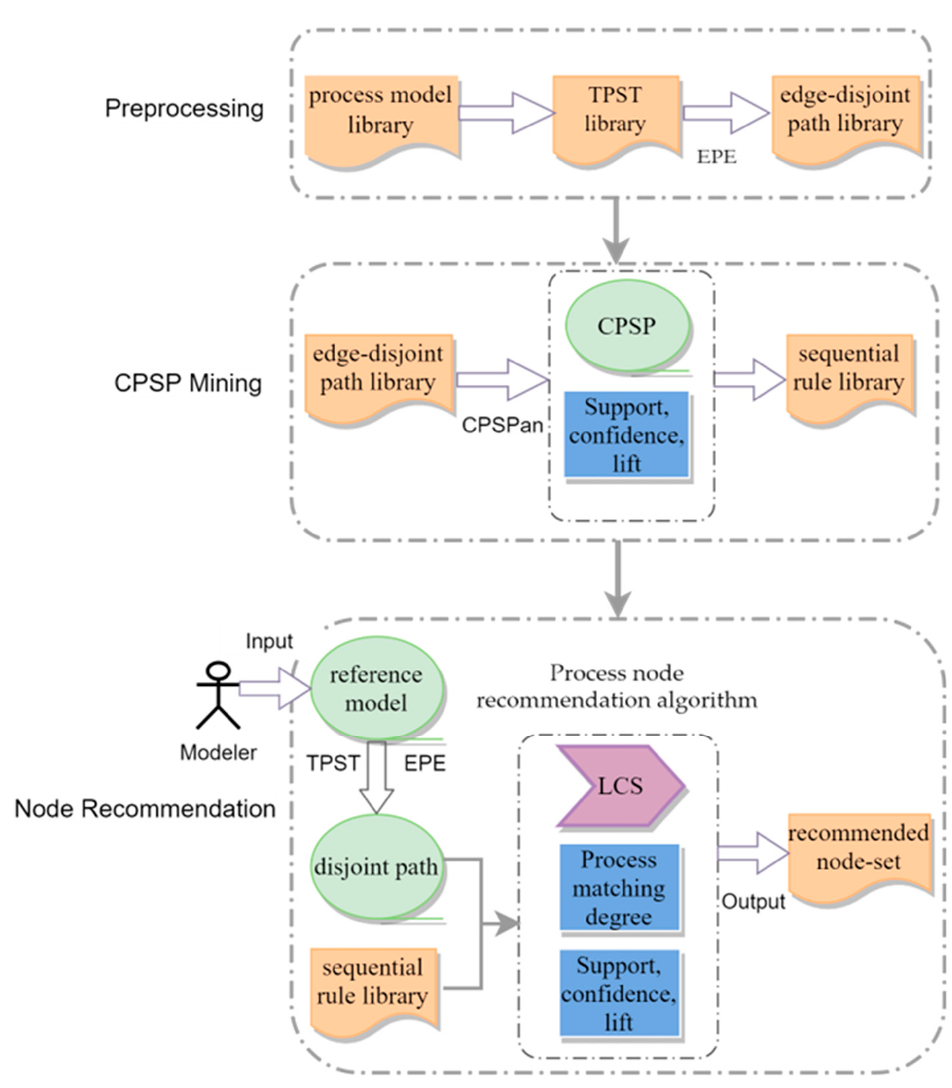
Figure 3. Business process recommendation framework.